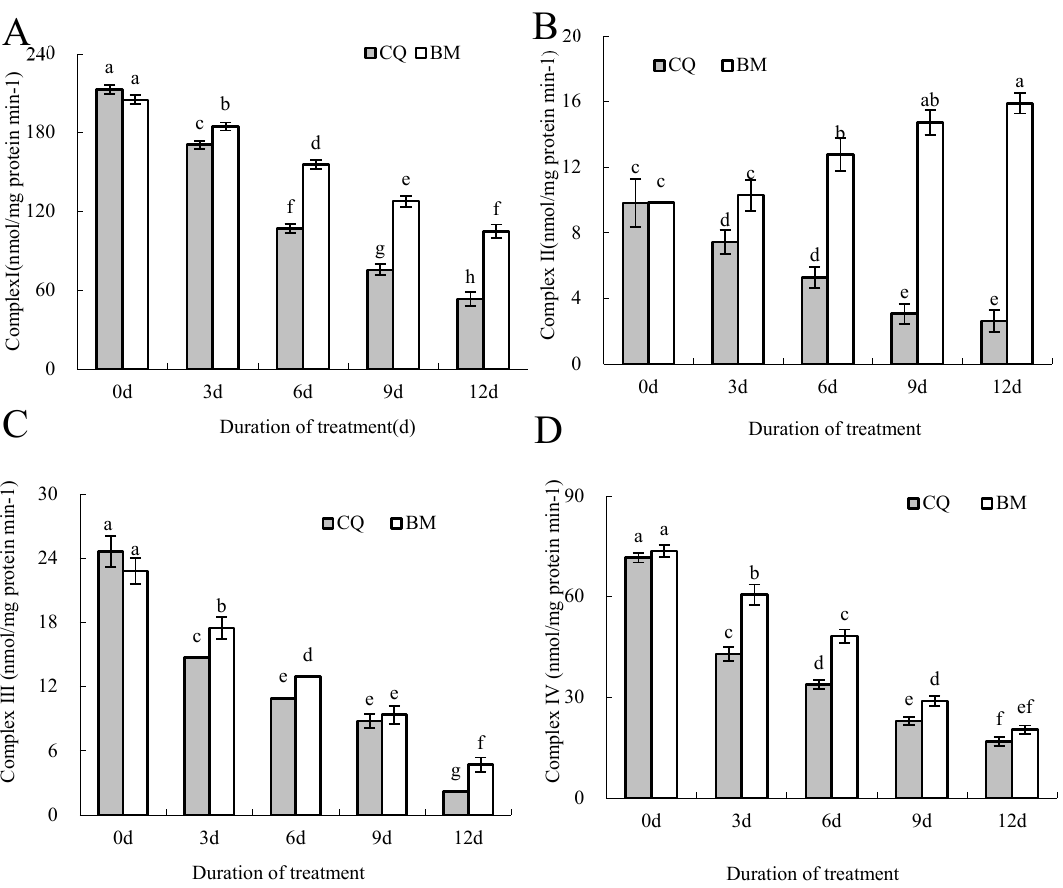
Figure 2. Determination of the activities of complex I—NADH/ubiquinone oxidoreductase ( A ), complex II—succinate dehydrogenase ( B ), complex III—ubiquinol/cytochrome c reductase ( C ), and complex IV—cytochrome c oxidase ( D ) in the mitochondria of cucumber roots at 0, 3, 6, 9, and 12 days after Ca(NO3) 2 treatment. Values are the means of three independent experiments. Bars marked with dissimilar letters are significantly different according to Duncan’s multiple range tests ( p < 0.05).